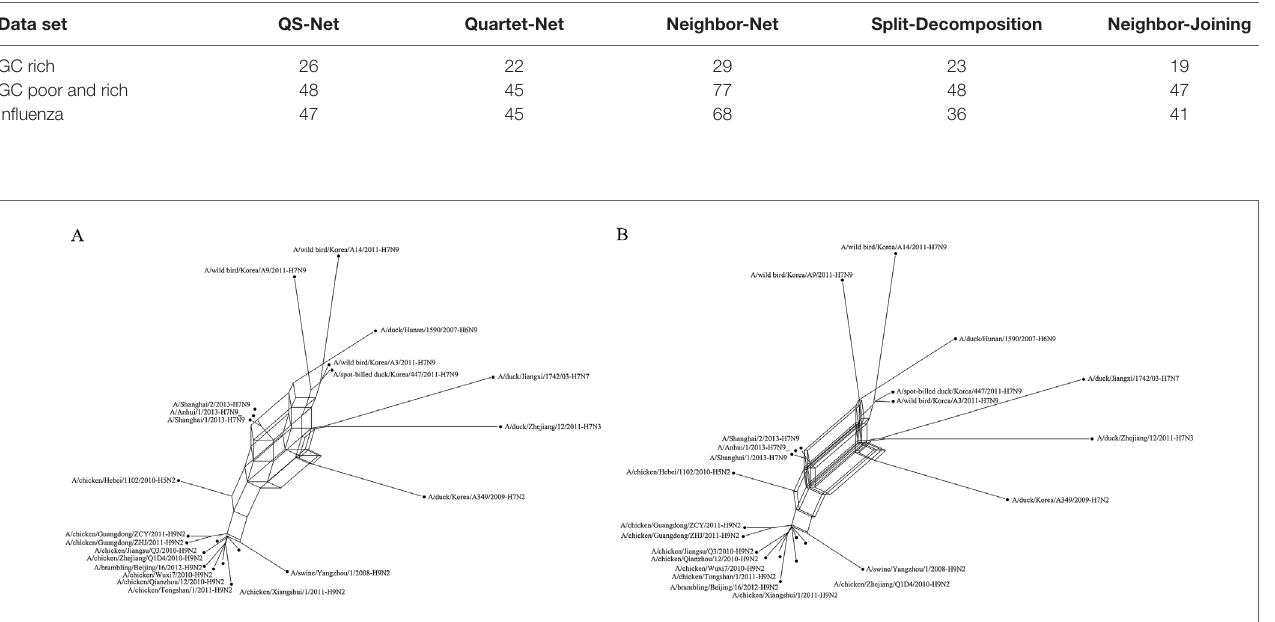
FIGURE 5 | The reconstructed network on influenza data. (A) The reconstructed Quartet-Net network related to H7N9 influenza A viruses. (B) The reconstructed QS-Net network related to H7N9 influenza A